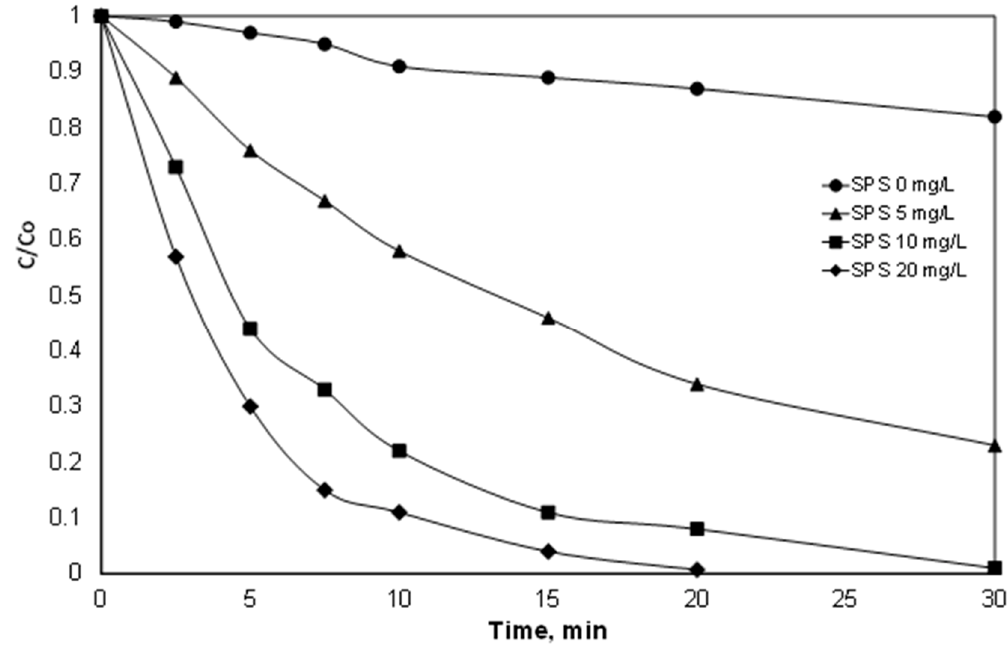
Figure 1. Effect of sodium persulfate on the degradation of 500 µ g/L PIR. [Fe 2+ ] = 2 mg/L, ultrapure water and inherent pH.